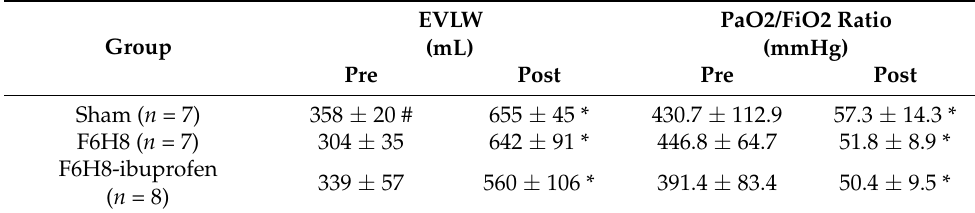
Table 2. Lung mechanics pre- and post-lung injury as well as at the end of the experiment. Peak Pressure Group (mbar) Pre Post End Pre Post End Pre Post